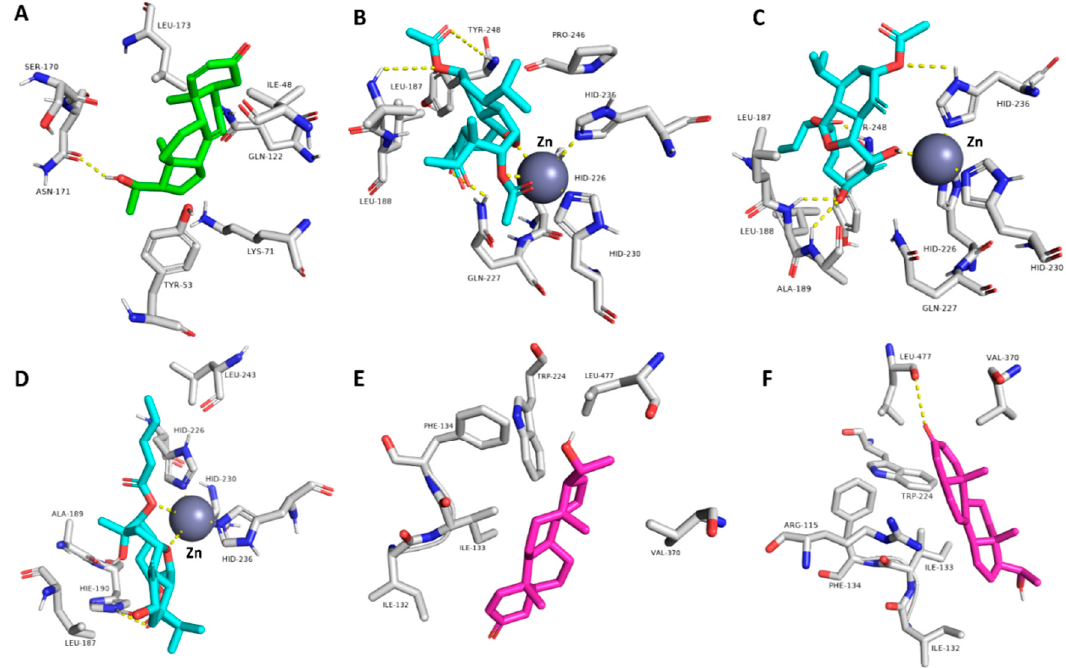
Figure 15. ( A ) Binding mode of compound 6 inside the active site of MAP kinase ERK1 (ERK1; green ‐ colored compound); ( B – D ) binding modes of compounds 7 – 9 , respectively, inside the active site of matrix metalloproteinase ‐ 9 (MMP9; cyan ‐ colored compounds); ( E , F ) binding modes of compounds 5 and 6, respectively, inside the active site of cytochrome P450 19A1 (aromatase, CYP19A1; pink ‐ colored compounds). All of these binding modes were the last snapshot derived from MDS of each compound ‐ protein complex.